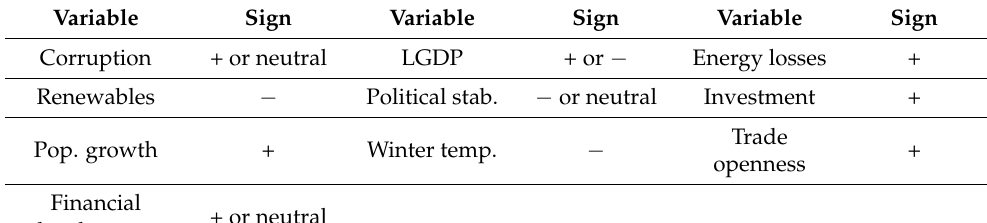
Table 2. Direction of the regression with the dependent variable (energy consumption). Variable Sign Variable Sign Variable Sign